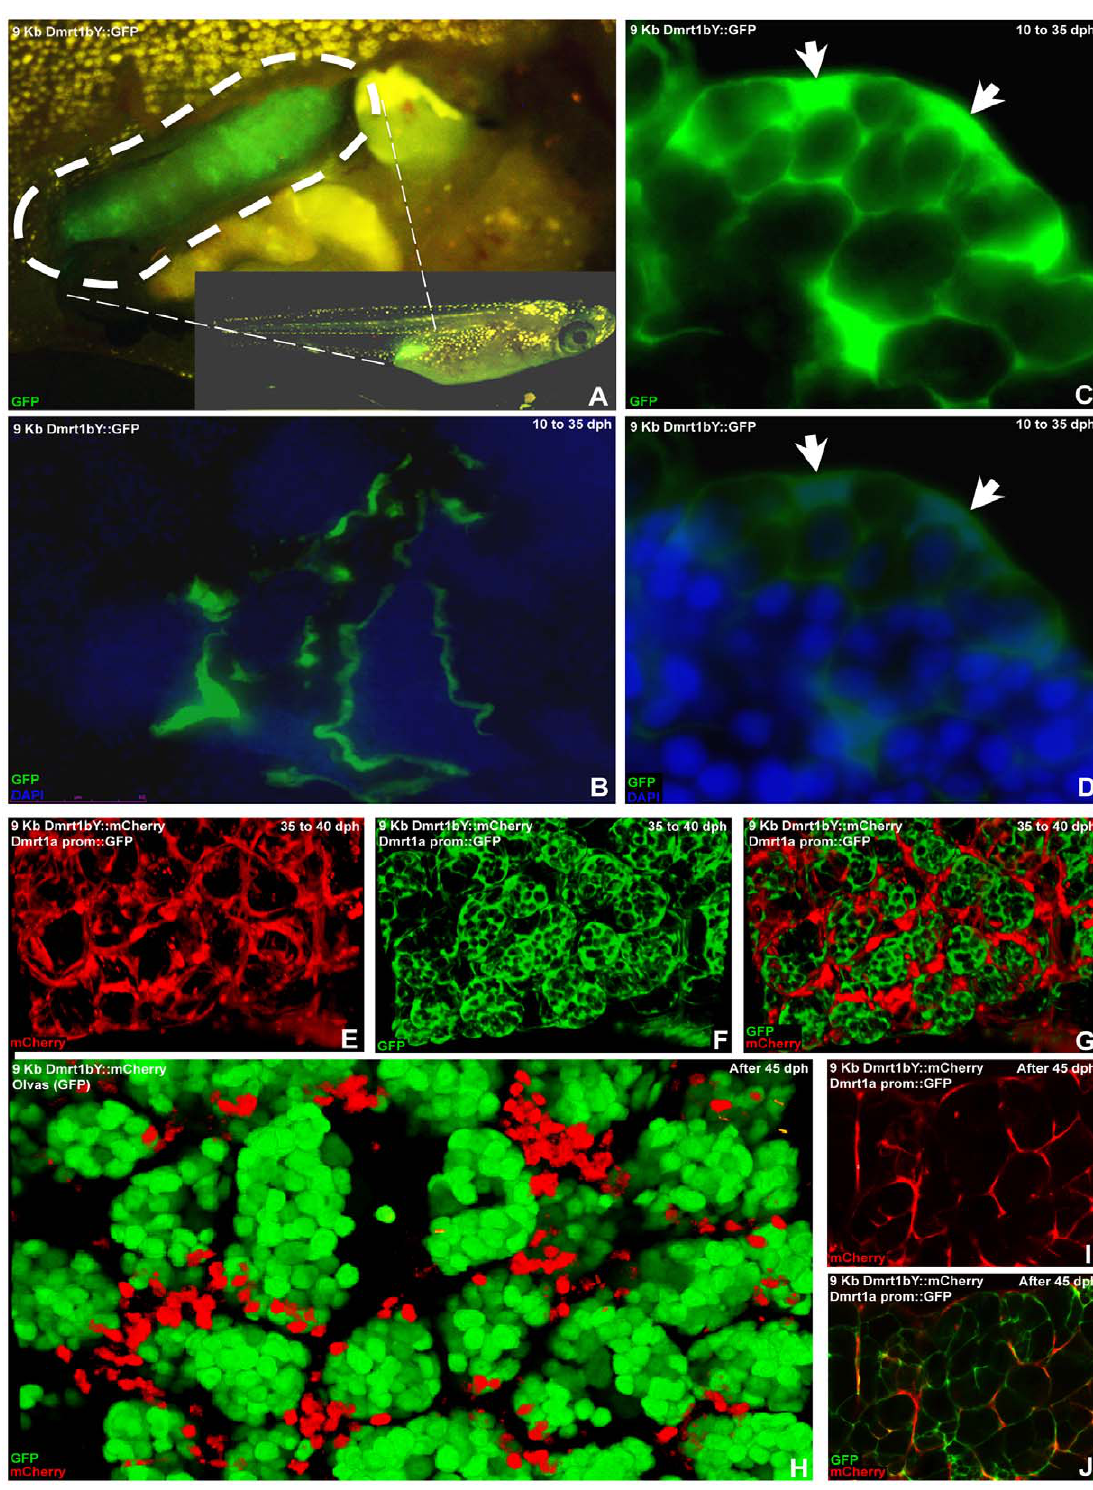
Figure 7. Invivo visualization of expression of the two medaka Dmrt1 paralogs. (A) Testis-specific GFP expression in 9KbDmrt1bYprom::GFP transgenic fish. (B) From testis formation (10 dph) up to adulthood, in 9KbDmrt1bYprom::GFP transgenic fish, robust testicular GFP expression is persistently noticeable in the epithelial cells of the intratesticular efferent duct. (C,D) Concomitantly, in agreement with the endogenous dmrt1bY expression, from 10 dph upto30–35 dphstrongspecificGFPfluorescenceisalsodetectedinSertolicells.(E–G,I,J)By35 dph,Sertolicell-specificdeclineinfluorescence(mCherry)could beobserved(E,I,H).Indoubletransgenicfish(9KbDmrt1bYprom::mCherryandBACdmrt1a::GFP)this9KbDmrt1bYprom-drivenmCherrydeclineinexpressionis balanced by the rise of dmrt1a expression in Sertoli and germ cells (GFP in F,G,J). (H–J) In fully mature testes (after 45–50 dph), 9KbDmrt1bYprom-driven mCherry expression remains in scattered Sertoli cells around the germ cells (GFP in N) while Dmrt1a is now predominantly expressed in Sertoli cells (J).